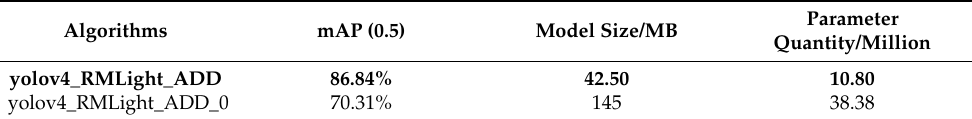
Table 4. The experimental results of improving the effectiveness of the enhanced feature extrac- tion